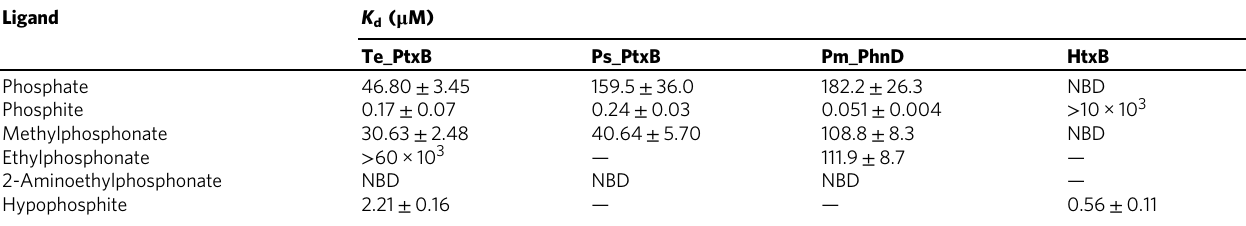
K d values presented are derived from fi ttingthree independent experimentsto Eq. (1) and errors reported as ± the estimated standard deviationof the K d . NBD indicates nobinding was detected up to a ligand concentration of 10mM; — indicates K d not